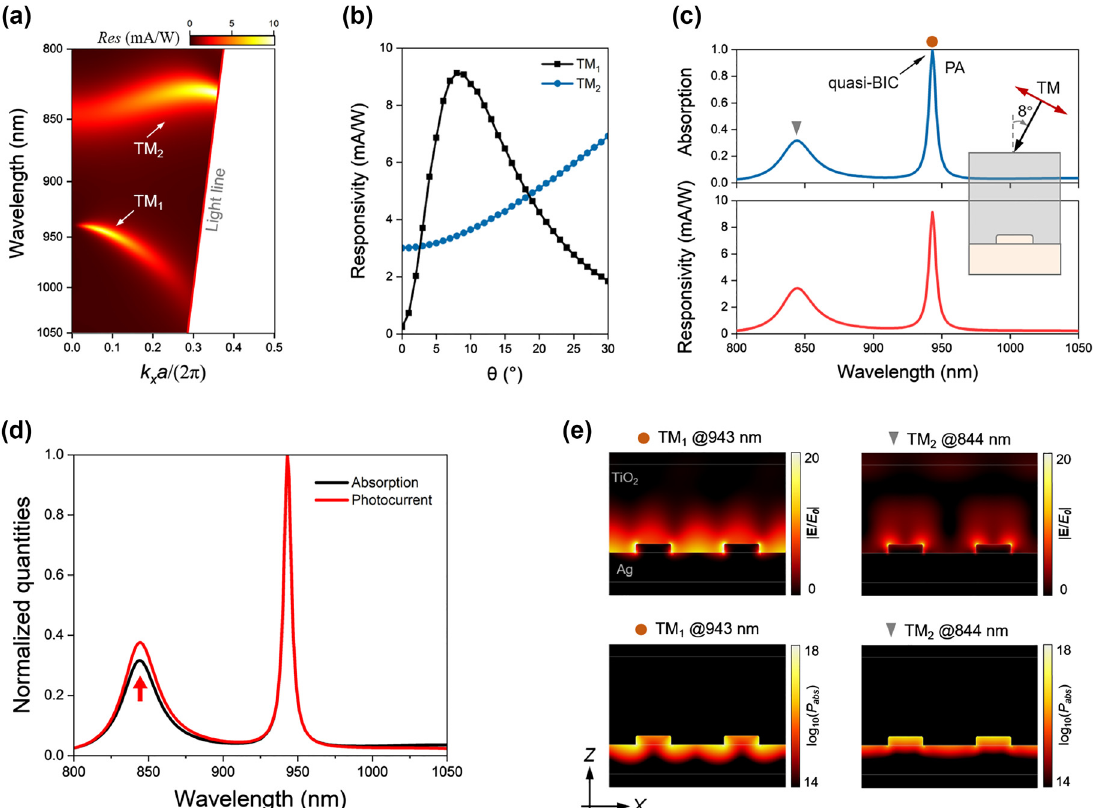
Figure 3: Enhancing HEPD with quasi-BIC. (a) Angle-resolved responsivity spectra of plasmonic structure under TM polarization. (b) Responsivity of TM 1 and TM 2 modes at different angles of incidence. (c) Absorption and responsivity spectra of plasmonic structure at an oblique incidence of 8 ° , where perfect absorption condition is satis fi ed at TM 1 mode. (d) Normalized absorption (black) and photocurrent (red) spectra of grating structure at an oblique incidenceof8 ° .(e)Electric fi eldand P abs distributionsatTM 1 andTM 2